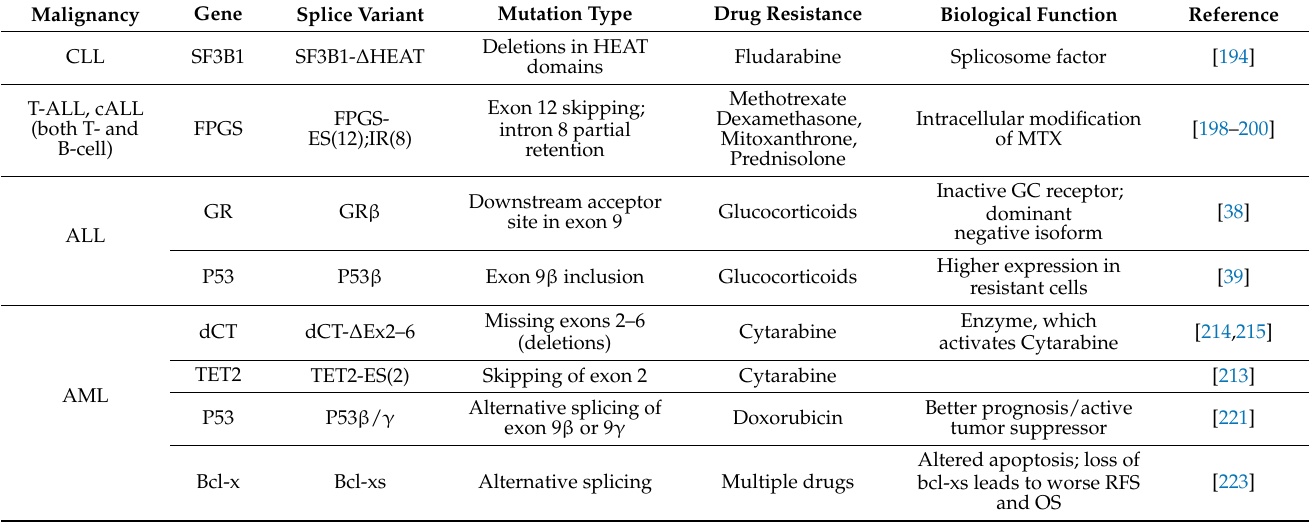
Table 6. AS and effects on drug resistance in hematologic